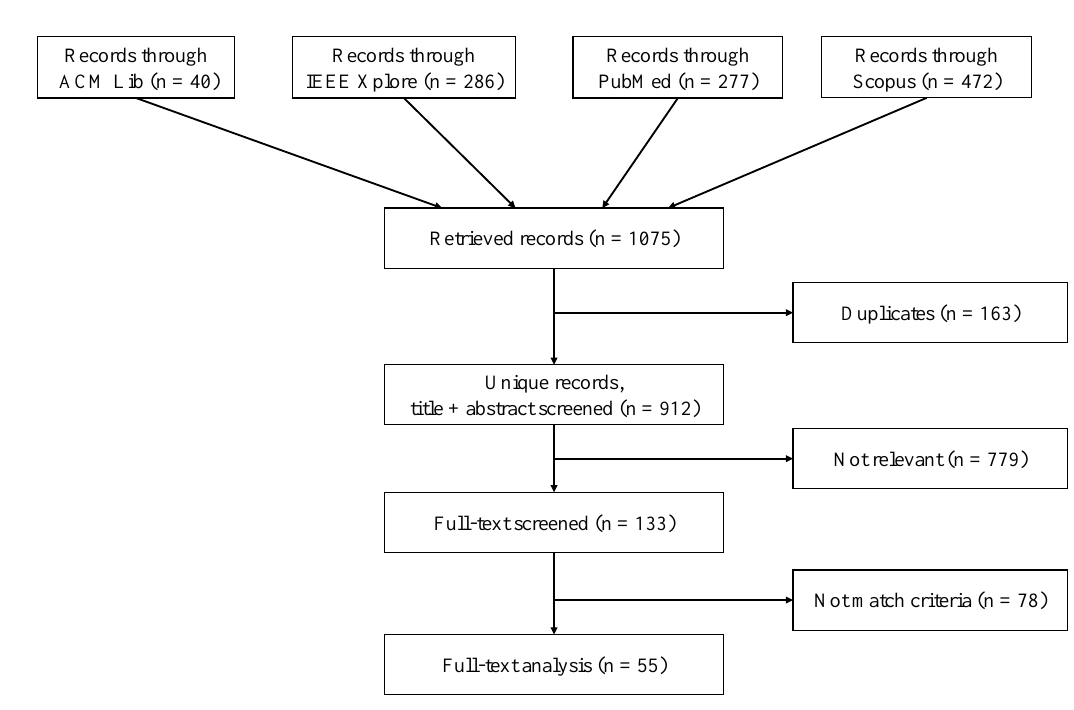
Figure 2. Review